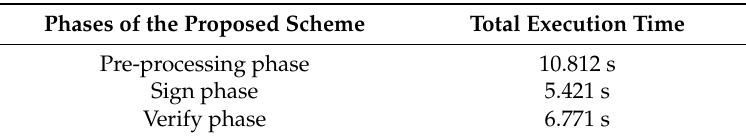
Table 3. The computation cost of our proposed signature scheme implemented on the Arduino Uno with a 160-bit elliptic curve, a 96-bit random number generator, and a 512-bit SHA-3.